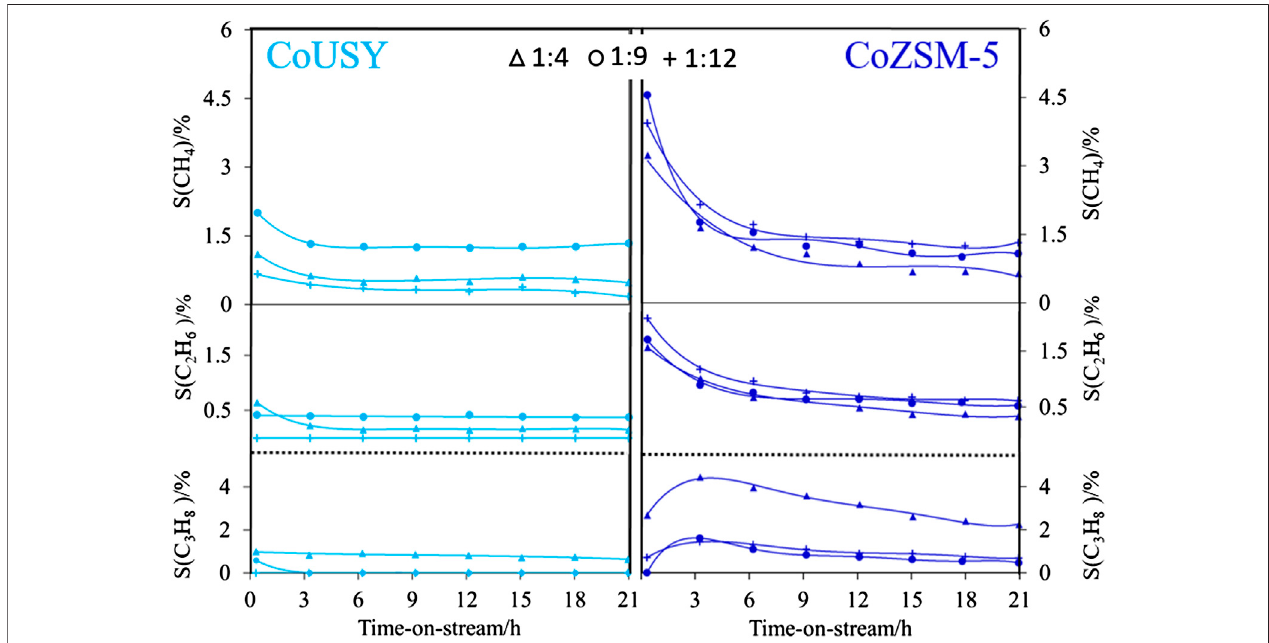
FIGURE 9 | Selectivity to residual products of the ESR process at 540 ° C for reaction mixtures with ethanol-to-water ratio of 1 : 4 ( Δ ), 1 : 9 (o), and 1 : 12 (+) for CoUSY (left column) and CoZSM-5 (right column) catalysts.